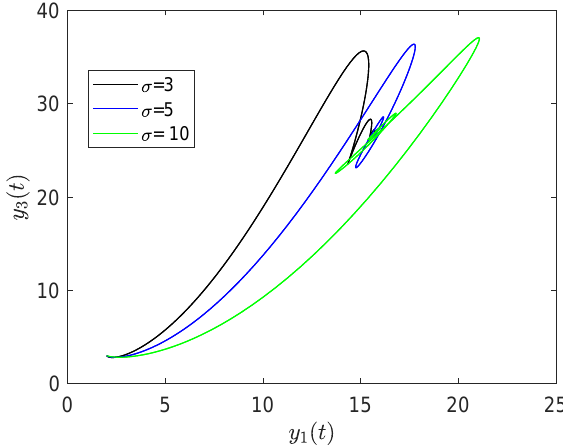
Figure 48. Phase portraits of y 1 and y 3 when varying σ